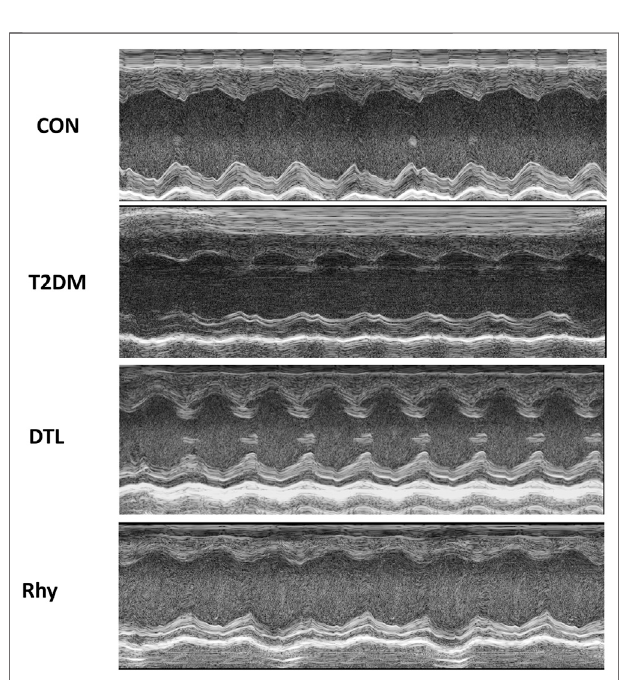
FIGURE 3 | The effects of rhynchophylline on the echocardiographic parameters. Representative M-mode images of left ventricular diameters and wall